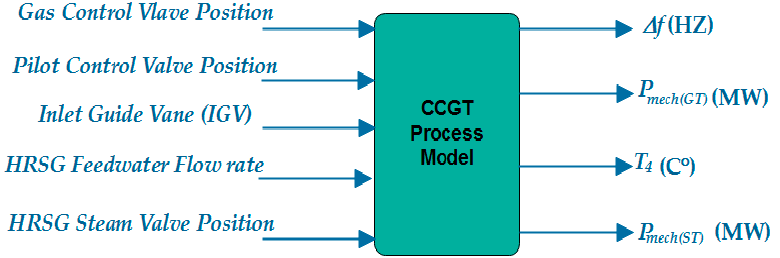
Figure 4. Typical process inputs–outputs for the combined cycle gas turbine (CCGT) process model.